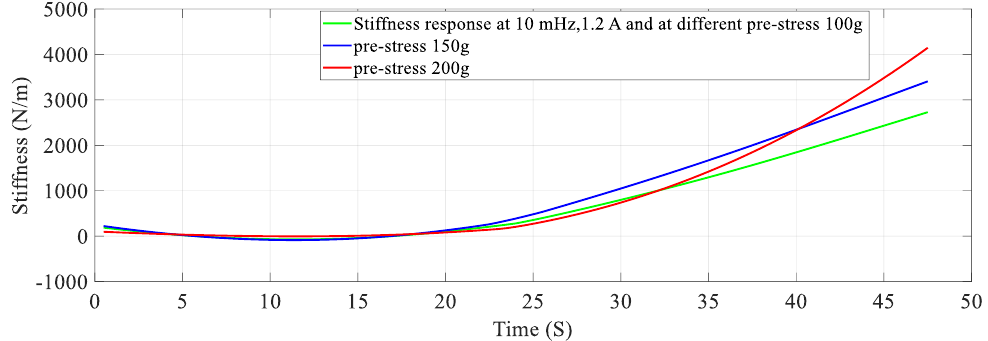
Figure 14. Stiffness response at different Pre − Stress.